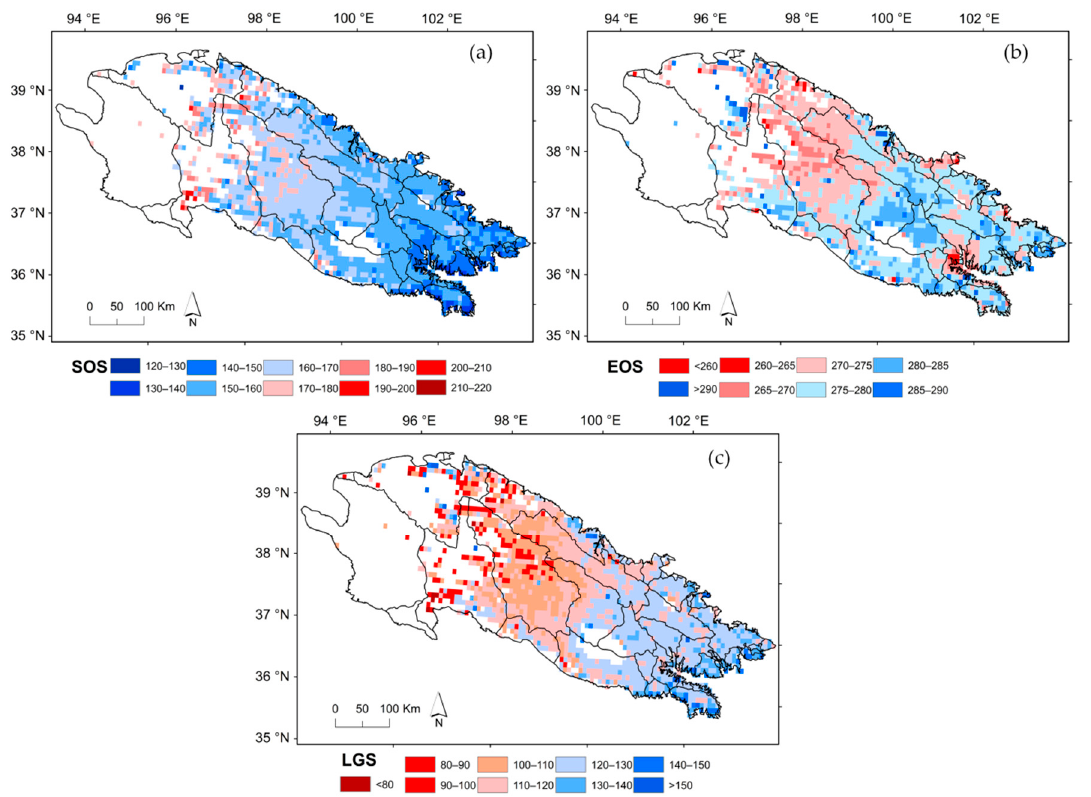
Figure 3. The spatial distribution of the multiyear mean SOS, EOS, and LGS for 34 years from 1982 to 2014 in the Qilian Mountains. ( a ) The spatial distribution of the multiyear mean SOS; ( b ) the spatial distribution of the multiyear mean EOS; ( c ) the spatial distribution of the multiyear mean LGS.